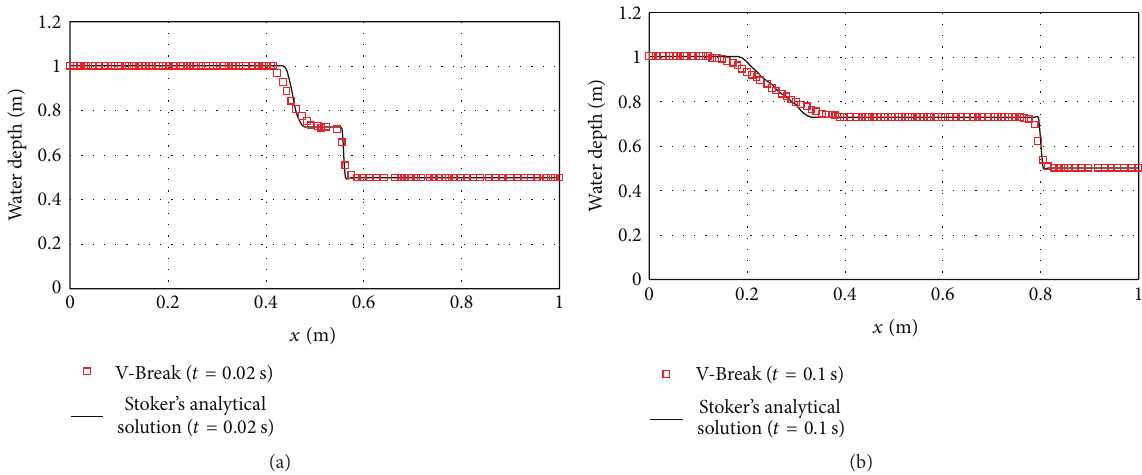
Figure 4: 1D Water depth values obtained using V-Break and Stoker’s analytical solution. (a) 1D water depth at 𝑡 = 0.02 s, (b) 1D water depth at 𝑡 = 0.1 s.